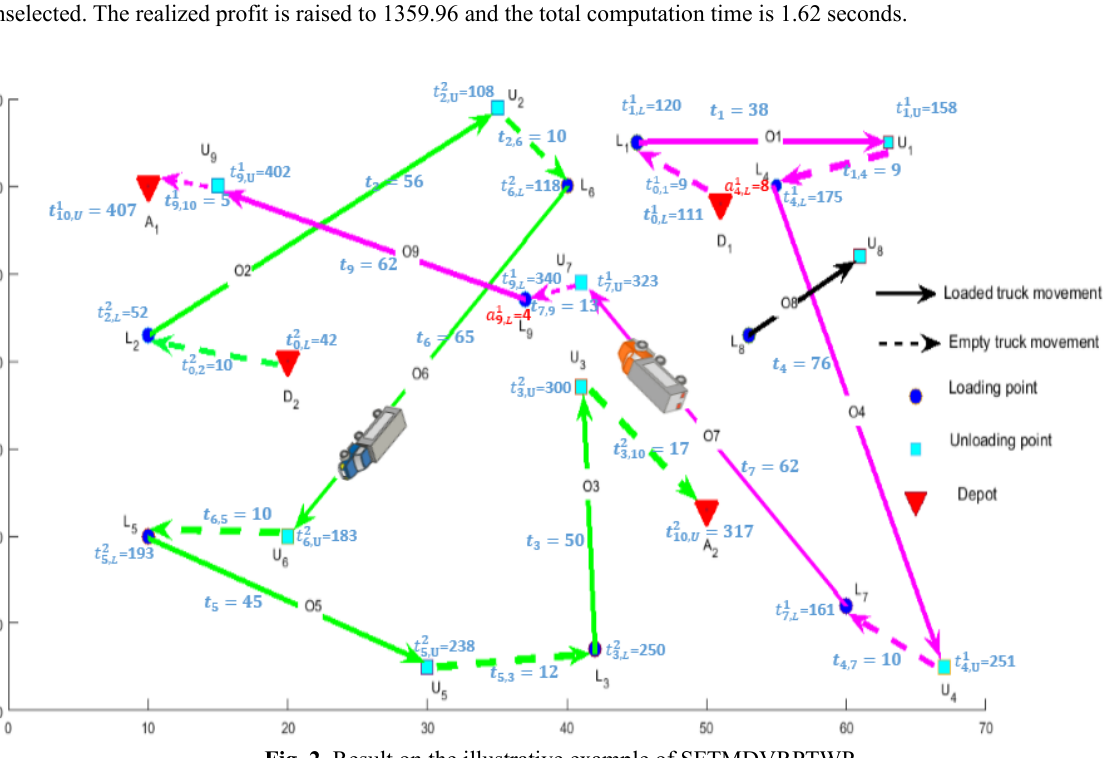
Fig. 2. Result on the illustrative example of